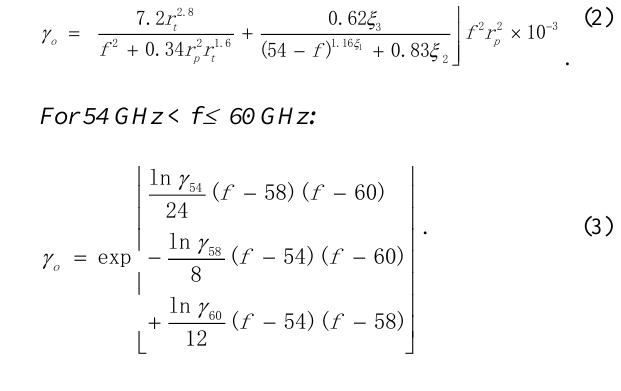
Figure 2. The satellite-earth link channel attenuation. According